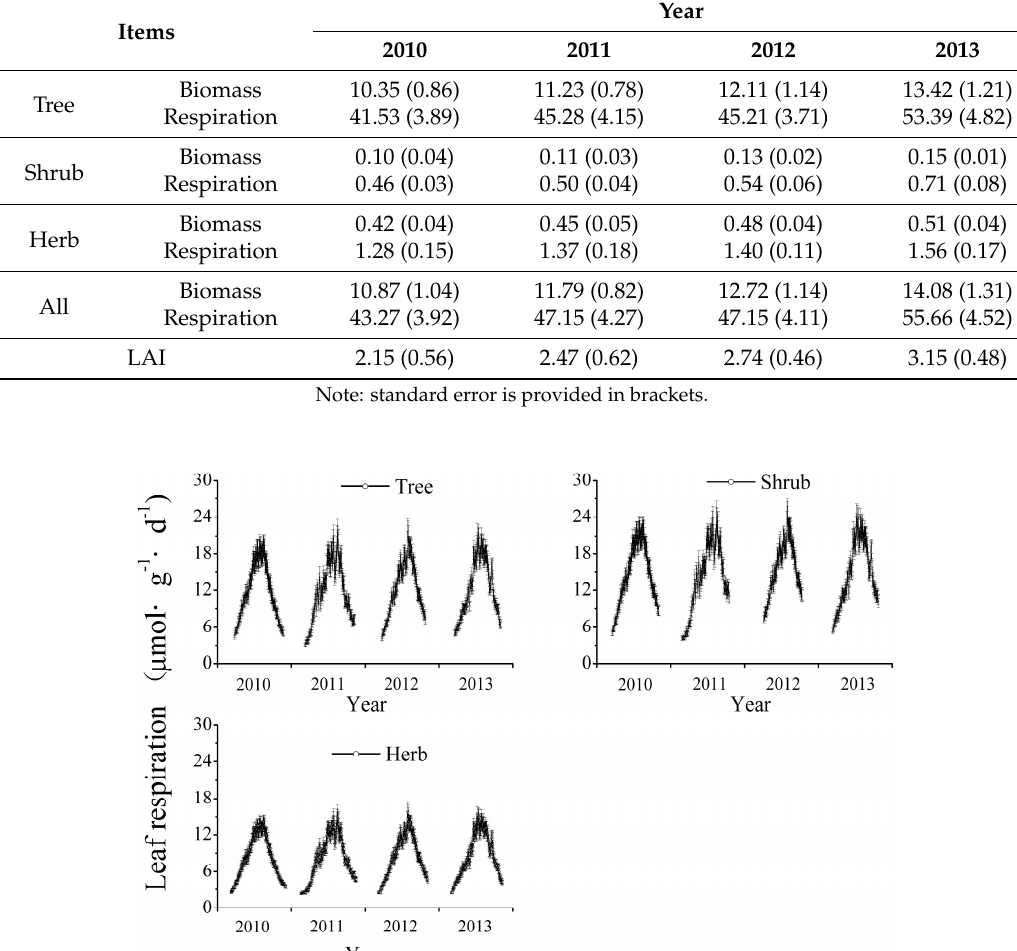
Figure 5. Daily mean soil, CWD, stem, leaf, and total ecosystem respiration in the L. principis- rupprechtii forest during 2010–2013. Error bars are based on 0.5 h soil temperatures and air temperatures as experimental unit, respectively ( n = 48).